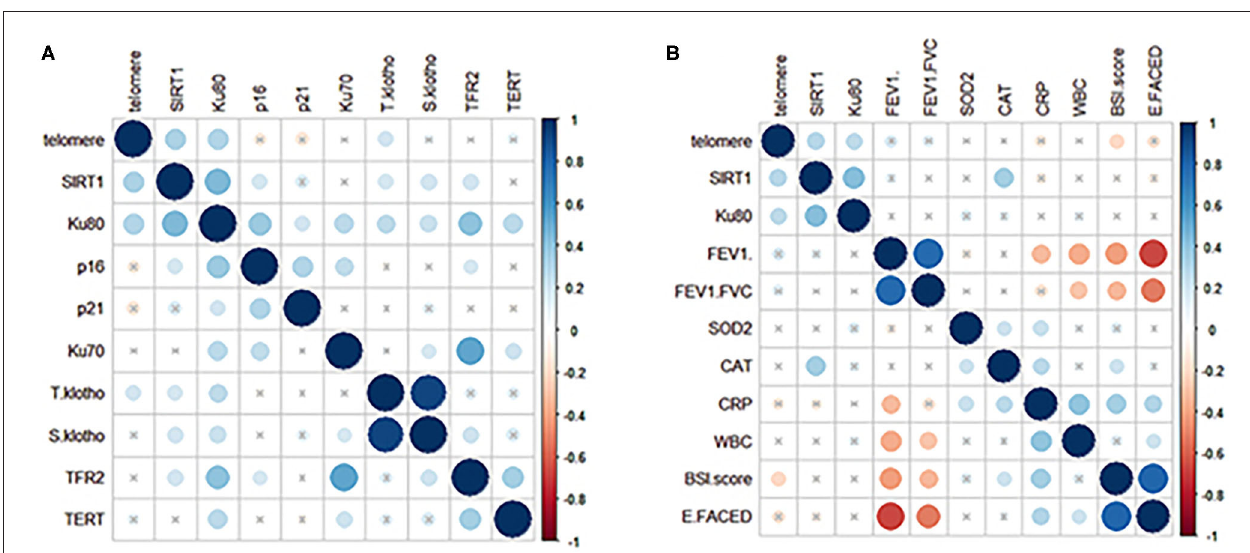
FIGURE 3 | Correlation between the expression levels of aging markers in peripheral blood and the clinical variables in patients with clinically stable bronchiectasis. (A) demonstrates the correlation coefficients (shown in different colors reflecting various magnitudes of correlation) for the expression levels of 10 aging markers in clinically stable bronchiectasis. (B) displays the correlation coefficients for the association between the clinical variables and the three aging markers, which were differentially expressed between patients with clinically stable bronchiectasis and healthy controls (relative telomere length, SIRT1, and Ku80). Blue dots represent positive correlation whereas red dots reflect negative correlation. Darker colors represent a greater magnitude of correlation. The cross-sign indicates the comparison with no statistical significance.